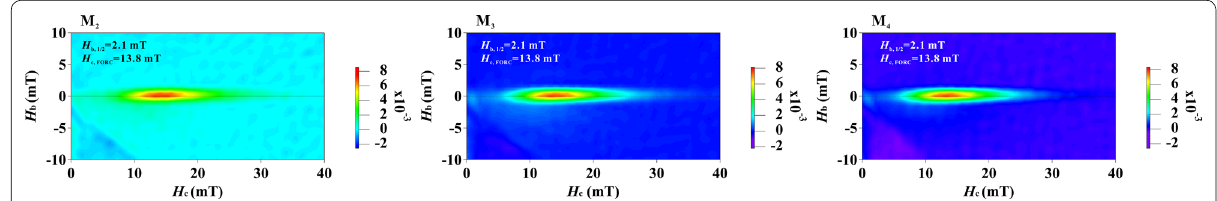
Fig. 2 FORCs diagrams of samples M 2 , M 3 and M 4 measured at room